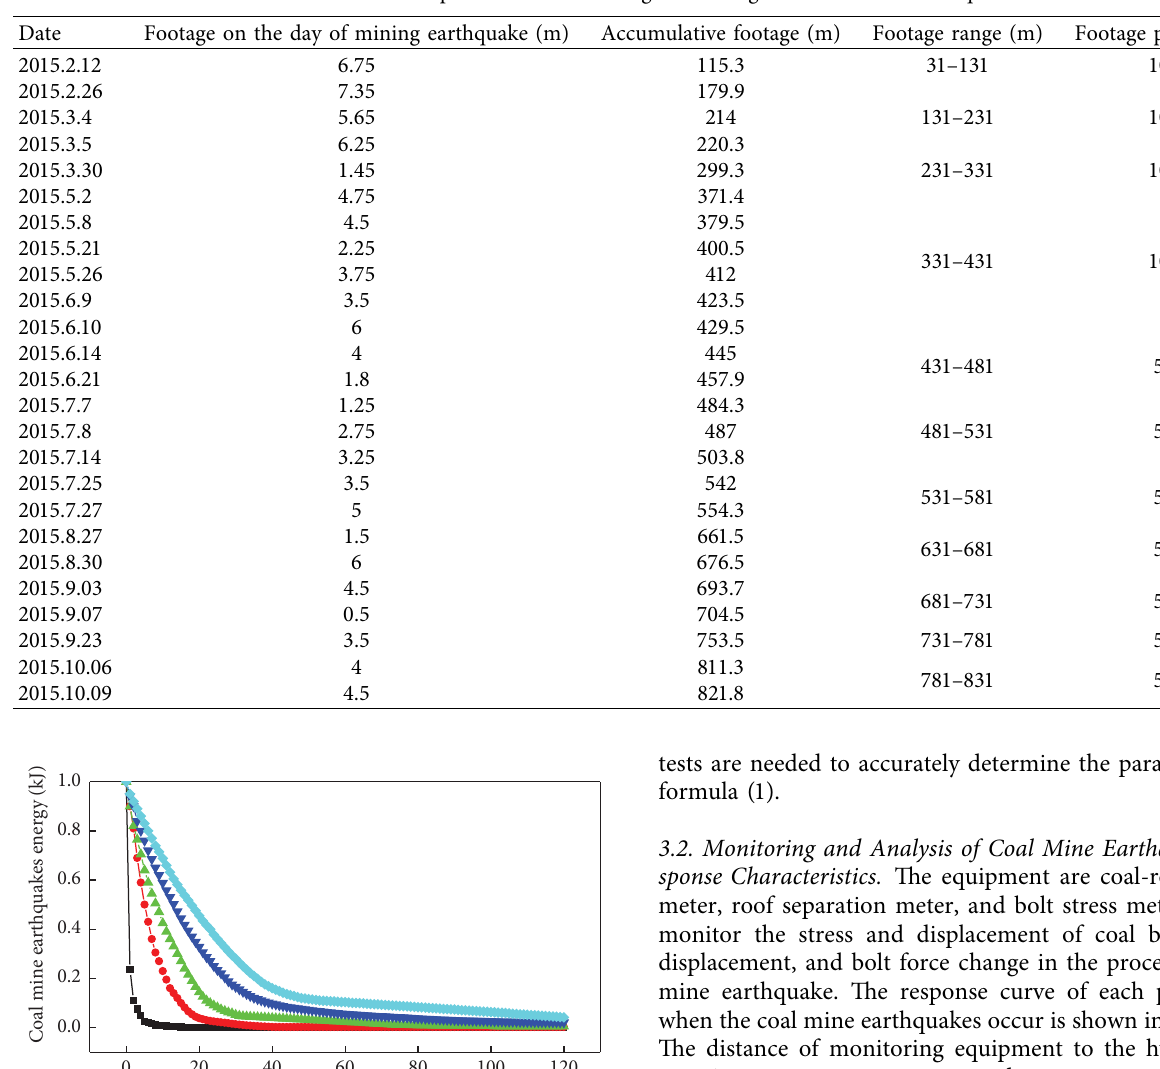
Table 1: Relationship between the working face footage and coal mine earthquake.